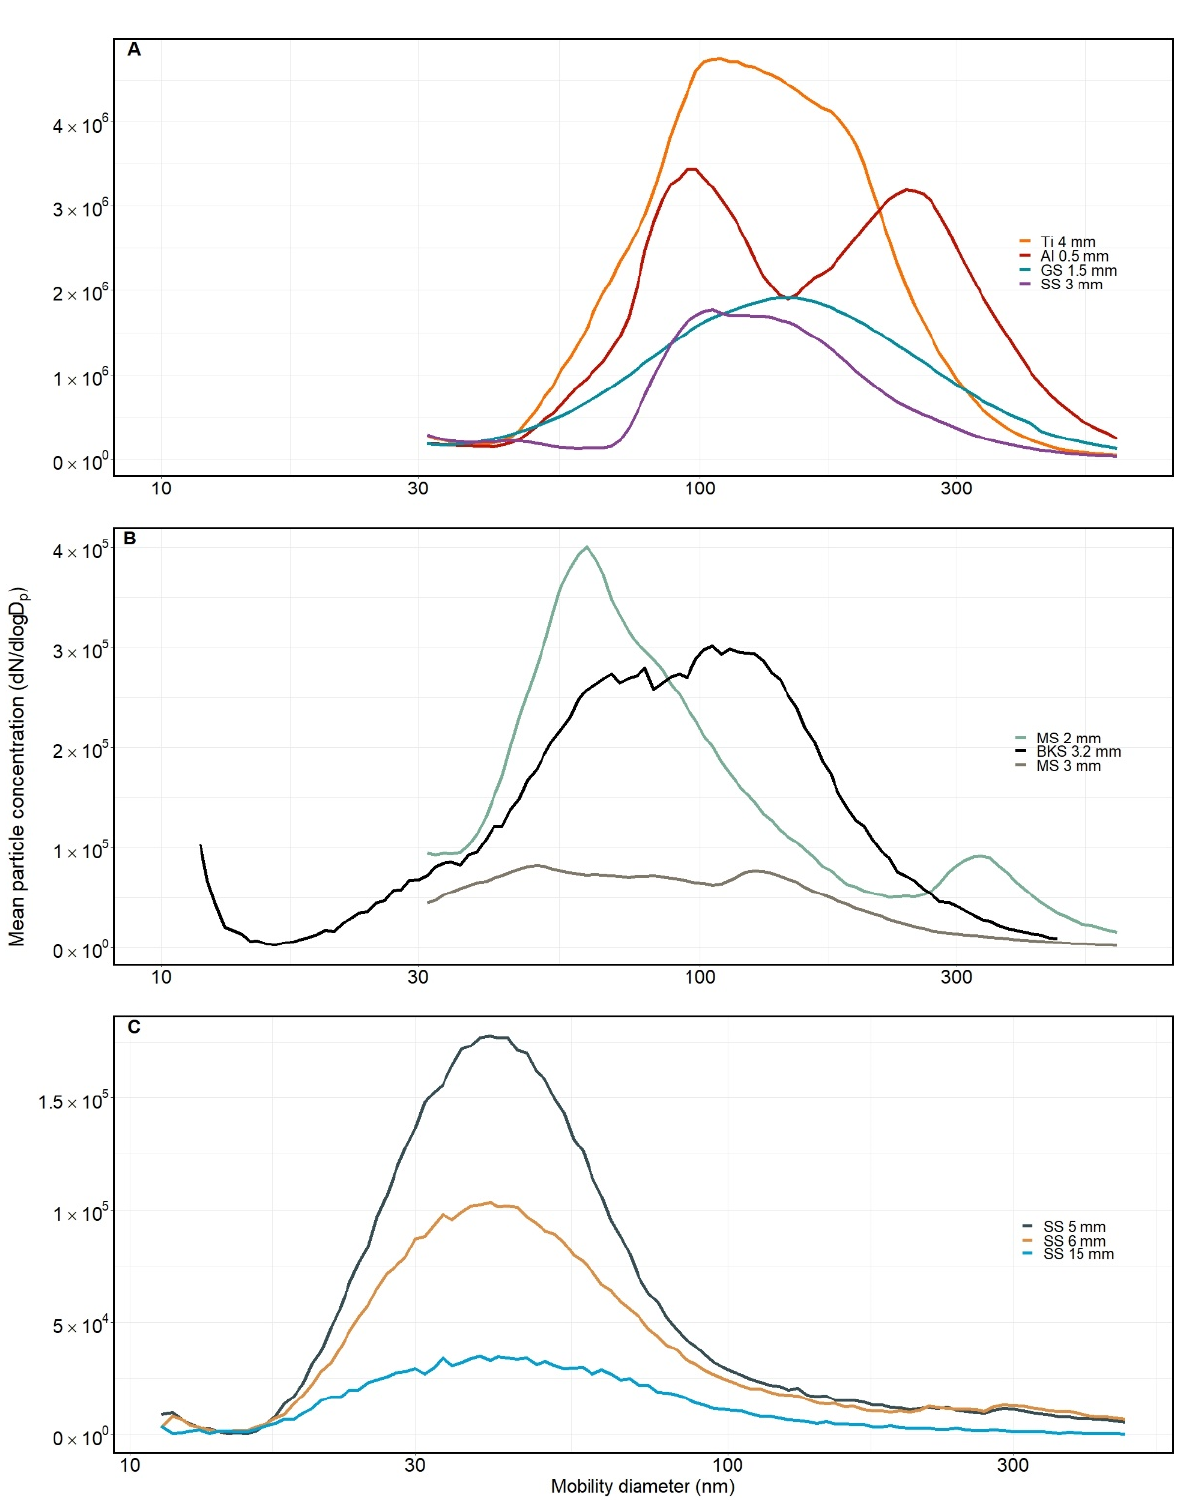
Figure 2. Particle size distribution for condensation particles from laser cutting of ( A ) aluminium- (Al), titanium- (Ti), galvanized steel (GS), and stainless steel (SS) sheets cut with a CO 2 laser; ( B ) black steel (BKS) and mild steel (MS) sheets cut with fibre and CO 2 laser, respectively, and ( C ) stainless steel (SS) sheets cut with a fibre laser.